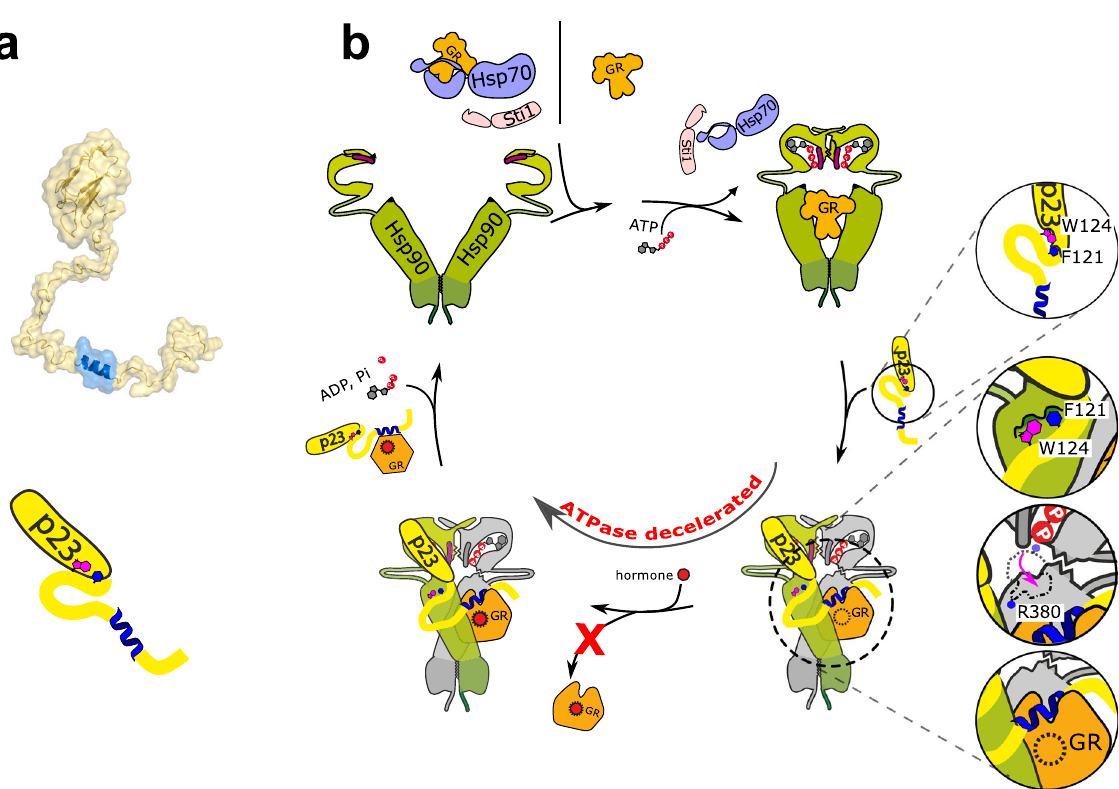
Fig. 7 Schematic model of p23 function in the Hsp90 chaperone cycle. a . Model of p23. The p23 tail has been modeled to the CS domain of yeast p23 (PDB: 2CG9) using PyMol 1.7.1.1. The tail helix is shown in blue. A schematic model is shown at the bottom. b . The GR either binds Hsp90 directly or is recruited from Hsp70 to Hsp90 via the adapter co-chaperone Sti1/Hop. PPIases compete with Sti1/Hop for Hsp90 binding and displace Sti1/Hop (not shown). In free p23, the W124 and F121 residues contact the core domain (1st inset). Upon binding to the ATP-bound, closed Hsp90 conformation, these aromatic residues bind a hydrophobic pocket on the Hsp90 middle domain (2nd inset). The inhibitory effect of p23 on the Hsp90 ATPase is caused by a shift of the catalytic loop conformation, which positions the R380 residue in a way that prevents ATP hydrolysis (3 rd inset). The C-terminal tail of p23 contains a helical segment, which interacts and stabilizes Hsp90-bound GR and prevents premature dissociation of the GR from Hsp90 (4 th